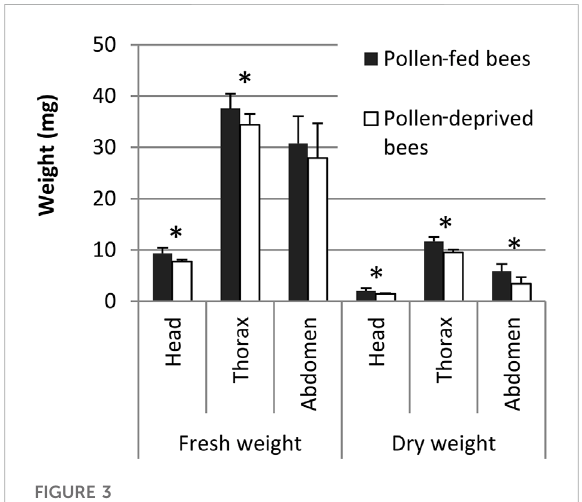
FIGURE 3 Fresh and dry weight of the head, thorax, and abdomen of pollen-fed bees and pollen-deprived bees from fl ight experiments. Means and standard deviations are shown: n = 24 – 26 bees. * indicates p < 0.05, Student ’ s t